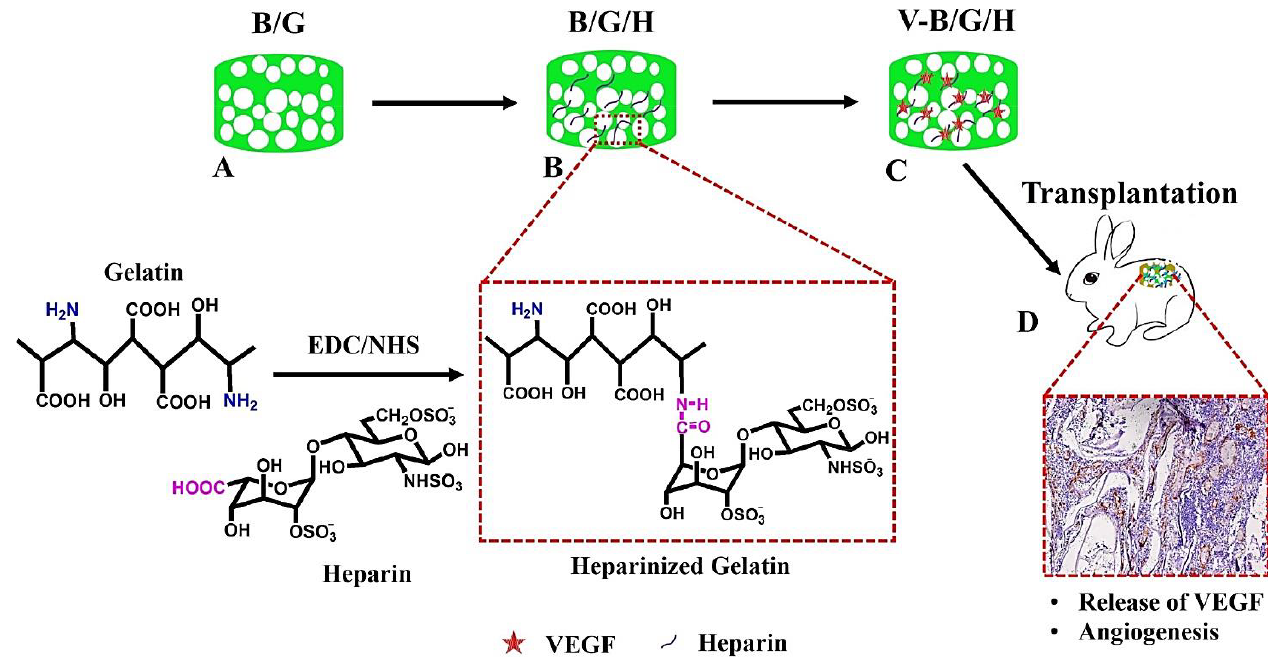
Figure 5. ( A – C ) The preparative strategy of VEGF-loaded 3D porous bacterial cellulose/gelatin scaffolds modified with heparin for vascularization and tissue regeneration purposes. After the condensation of the -COOH in the heparin and the -NH 2 in the gelatin, the scaffolds could be prepared for ( D ) subcutaneous transplantation to provide enhanced angiogenesis. NHS: N